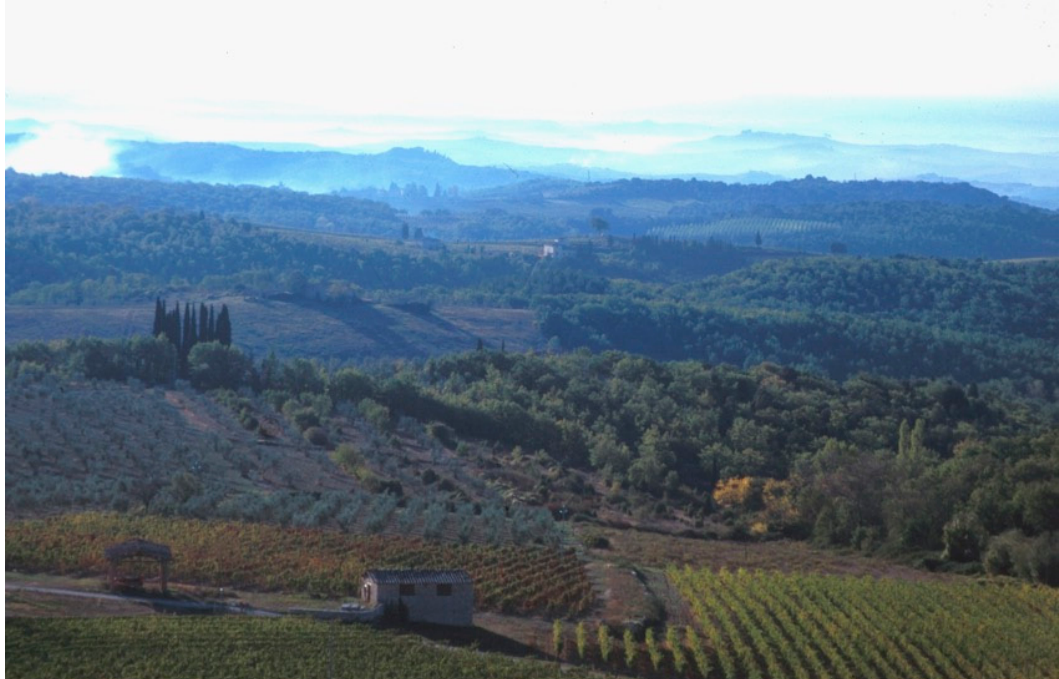
Figure 4. The Tuscan landscape is made of a mosaic of different land uses including forests, farmed and grazed land as well as rural settlements. The main task of the landscape plan is to maintain the quality of the landscape harmonizing economic, social and environmental processes.